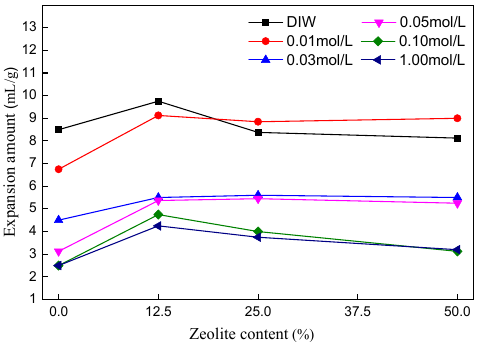
Figure 5. Variation of the swelling volume of mixed soil with different zeolite